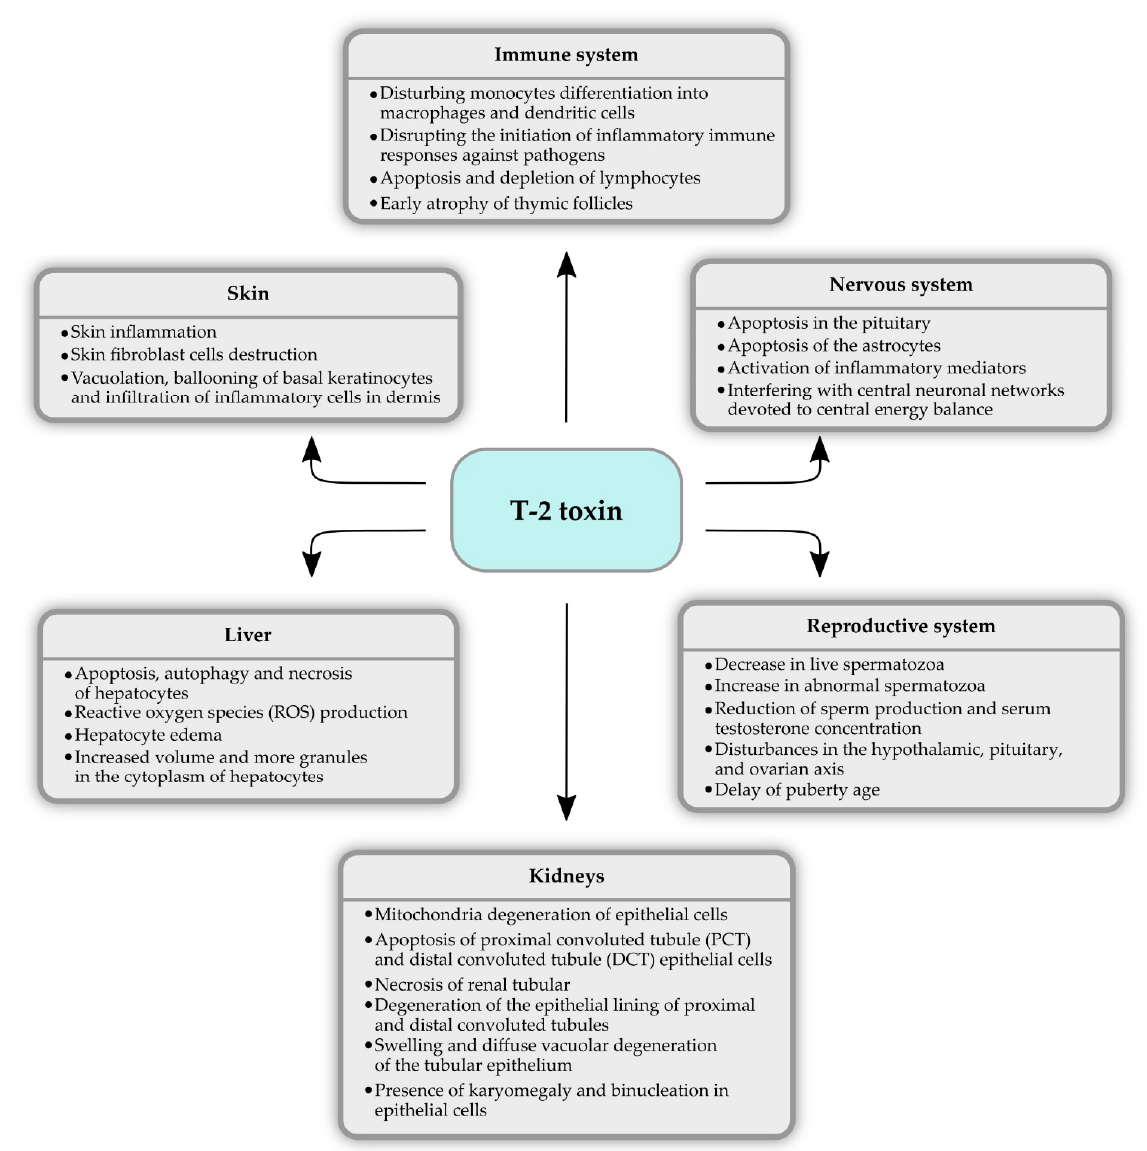
Figure 3. The main toxic effects of T-2 toxin in the organism.